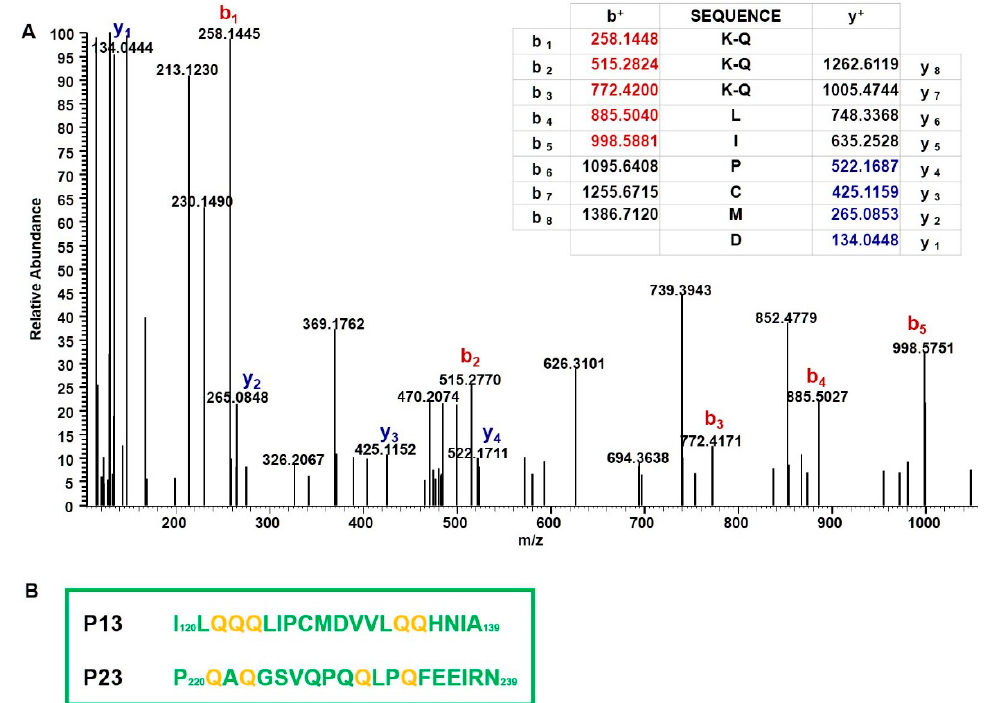
Figure 3. Identification of Q residues transamidated by mTG. ( A ) MS/MS spectrum of the peptide QQQLIPCMD (peptide 122–130 of the K-r-gliadin) containing three modified Q residues (precursor ion at m/z 507.257). The table included in the figure reports the theoretical b and y fragment ions for the fully modified peptide. Signals present in the MS/MS spectrum matched to b ions (highlighted in red) and y ions (highlighted in blue). K-Q refers to transamidated glutamine residues. ( B ) Amino acid sequence of p13 and p23. The glutamine residues transamidated by mTG sites are highlighted in yellow.